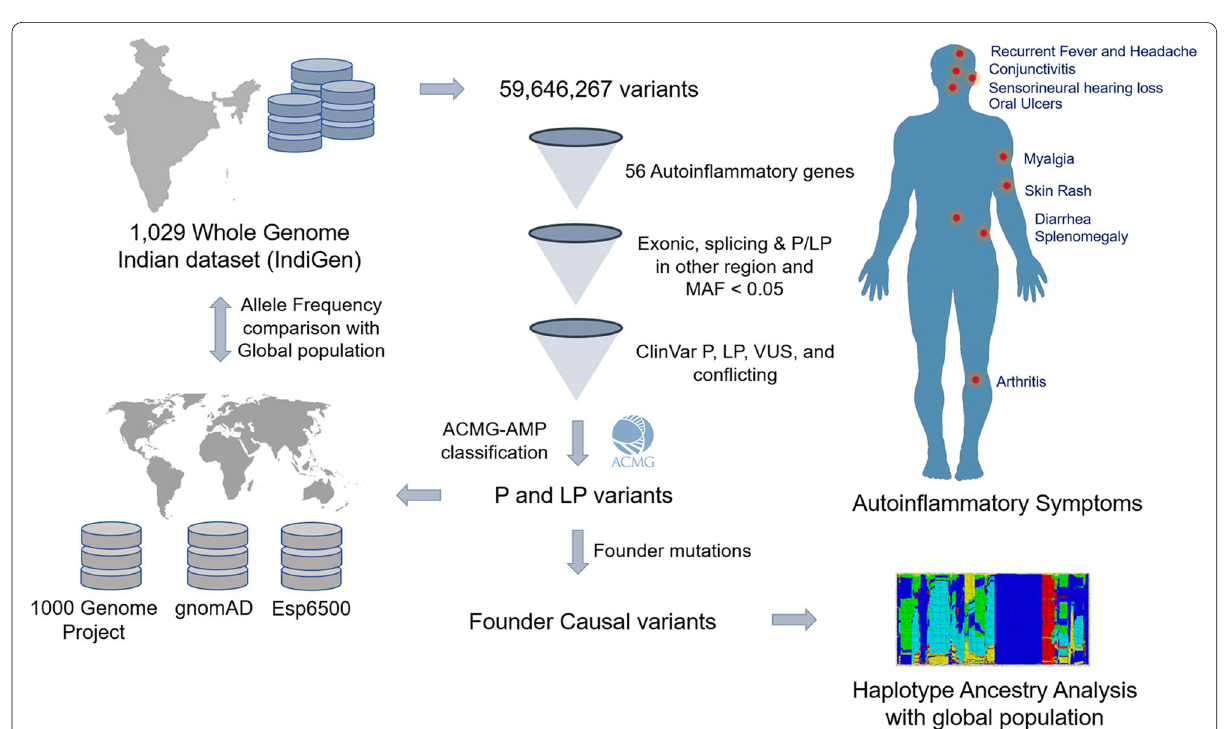
Fig. 1 Schematic summarizing the data analysis pipeline utilized in this